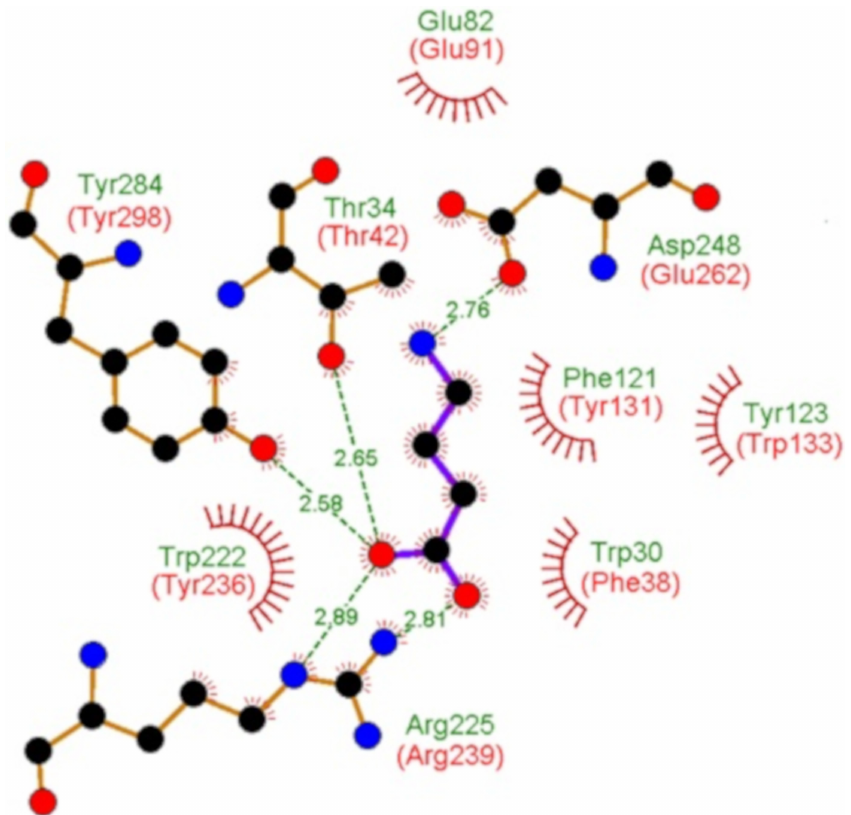
Figure 3. Evidence for specific GABA binding solute proteins in bacteria. Shown and annotated in green are amino acids that interact with bound GABA in the three dimensional structure of the specific GABA binding protein Atu4243 of Agrobacterium fabrum (pdb ID 4EUO). Annotated in red are the corresponding amino acids of PA0222 in its protein sequence alignment with Atu4243 (Figure